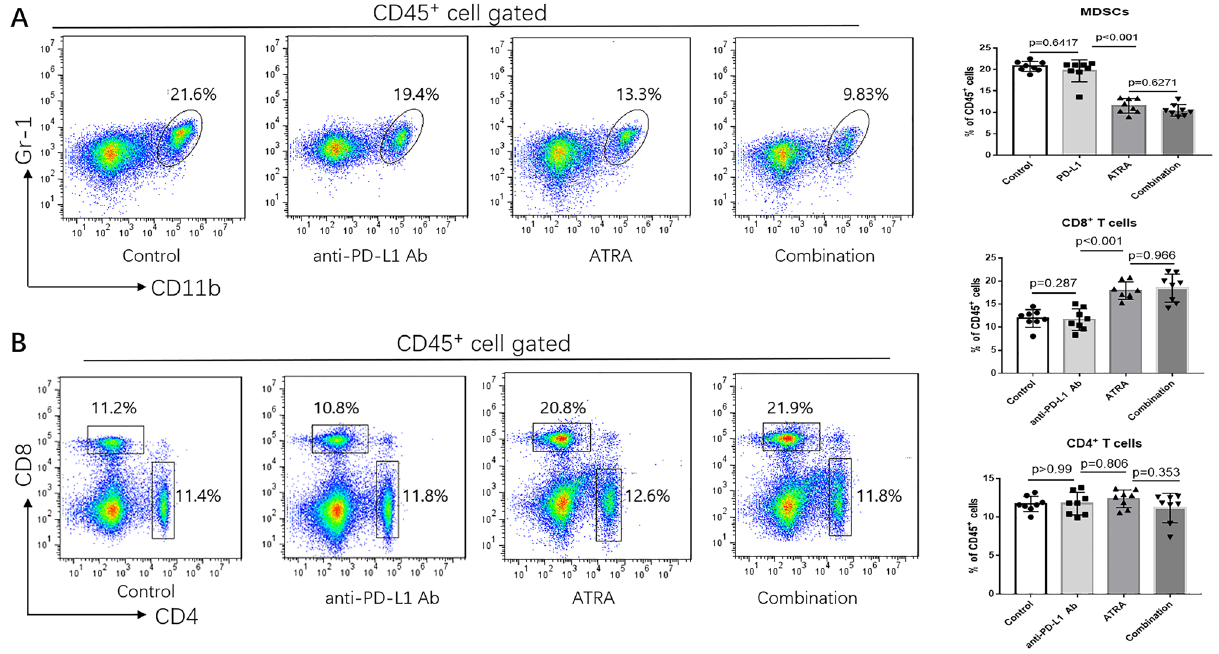
Figure 5. ATRA in vivo partially reversed MDSCs suppression and enhanced CD8 + T cell infiltration in tumor-bearing mice. At 21 days after inoculation, tumor tissues were harvested, and tumor-infiltrating CD45 + immune cells were examined. Representative flow cytometry dot plots of MDSCs ( A ), CD4 + T cells and CD8 + T cells ( B ) in different treatment groups(left)and the comparison of the MDSCs, CD4 + T cells and CD8 + T cells proportions in different groups (right) are shown. Data are shown as mean ± SD (8 mice/group, 2 repetitions with similar results).